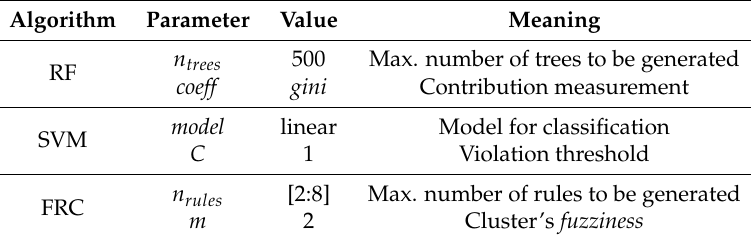
Table 3. Algorithms default configuration. FRC, fuzzy rule-based classifier.